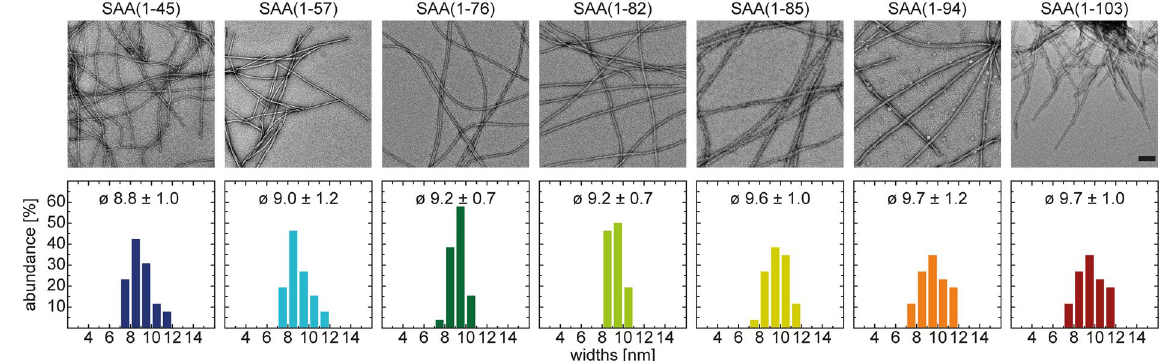
Figure 2. Quantitative analysis of fibrils formed in vitro from SAA(1–103) and AA proteins. ( A ) Negative-stain TEM images. Scale bar: 100 nm. ( B ) Distribution, mean value and standard deviation of the widths of respective fibrils (n = 30).